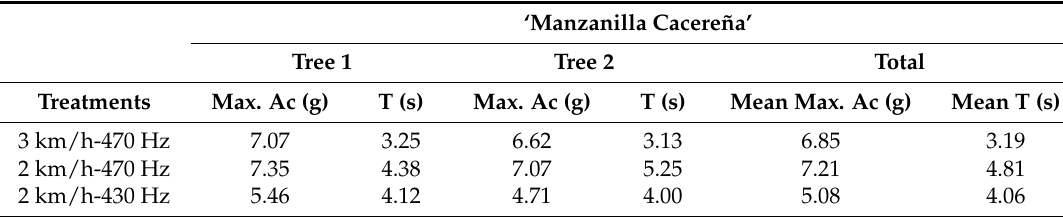
Table 6. Measurements of the maximum acceleration and vibration time suffered by olive trees using USB